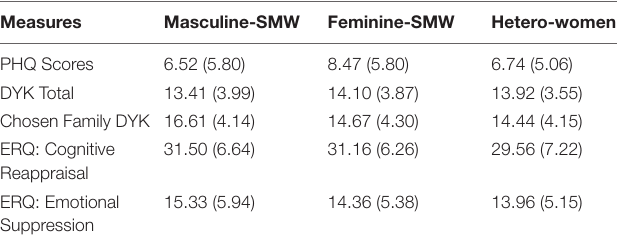
TABLE 1 | Comparison of means (standard deviations) of measures across groups.